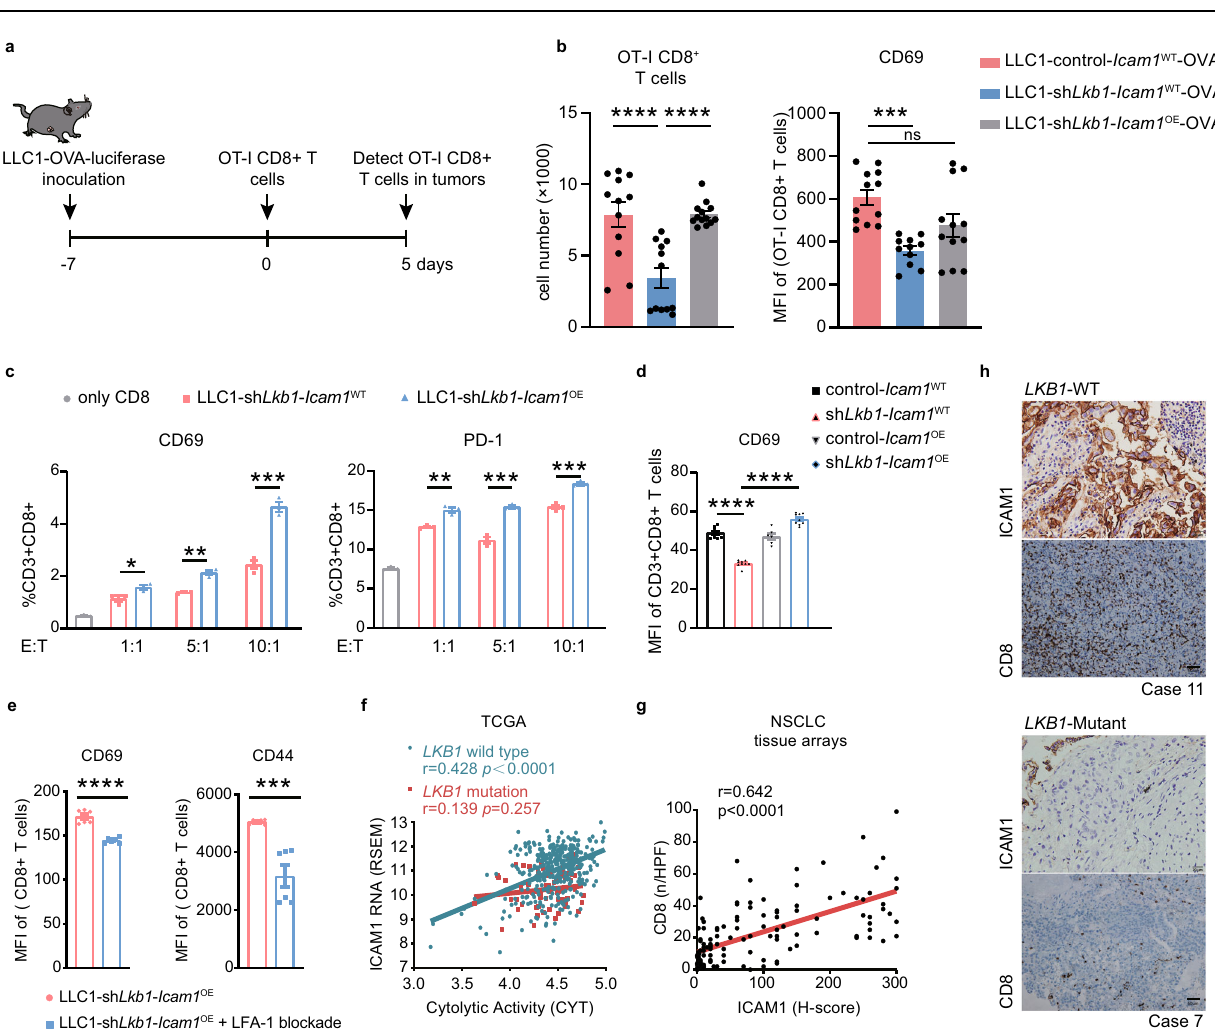
tumors than LLC1-sh Lkb1 - Icam1 WT -OVA groups (Fig. 3b). Besides, ICAM1 overexpression signi fi cantly improved the activated state of OT-I CTLs (CD69) in Lkb1- de fi cient tumors (Fig. 3b). Taken together,